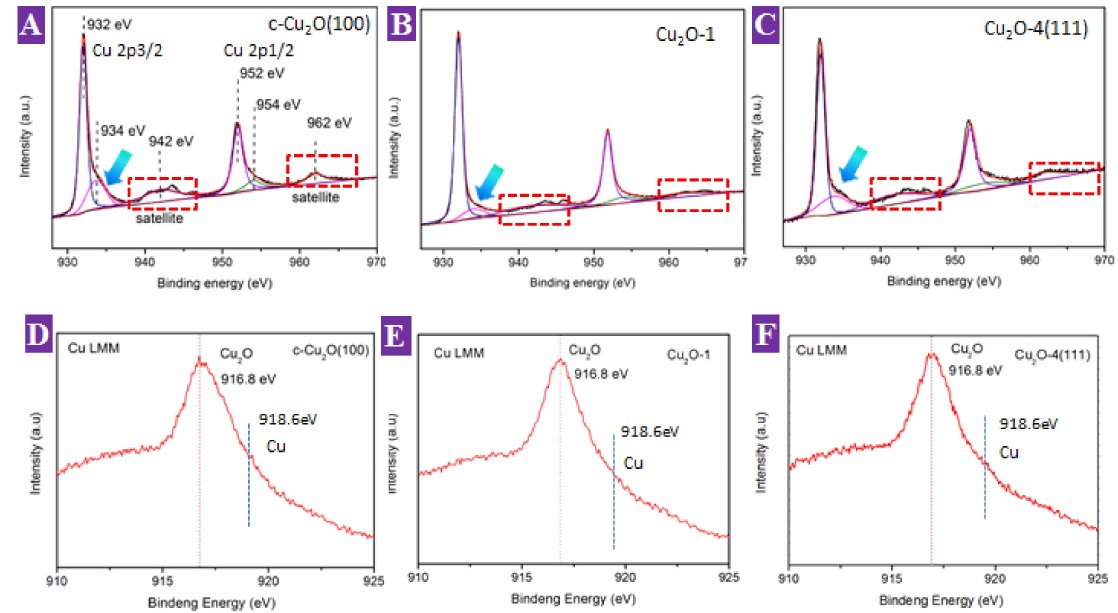
Figure 5. XPS spectra of the as-prepared samples. ( A – C ) Cu2p high-resolution spectra of, ( D – F ) Cu LMM of c-Cu 2 O(100), Cu 2 O-1 and Cu 2 O-4(111),